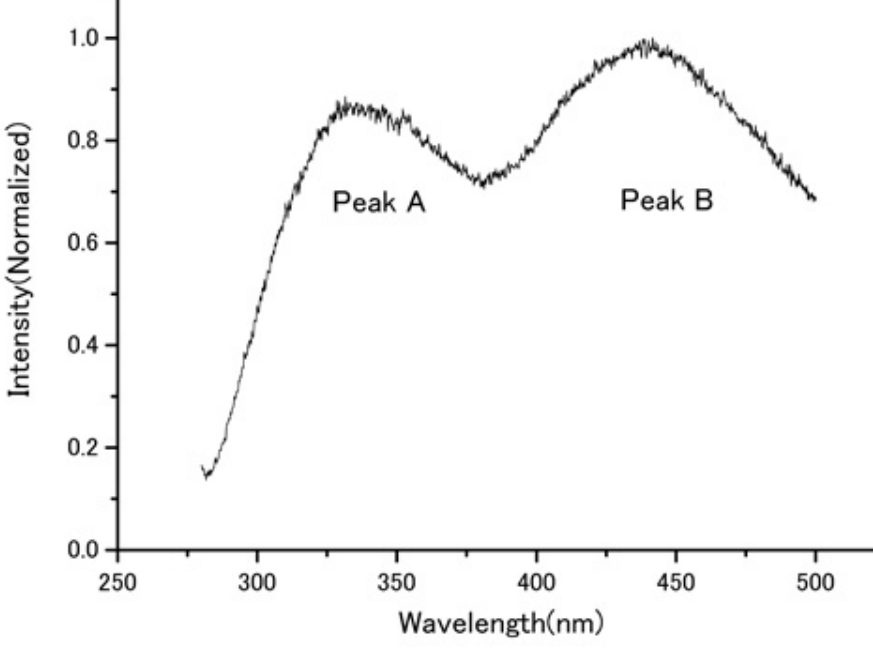
FIGURE 2 . Typical UV fluorescence spectrum of a fingerprint on quartz glass excited by 266-nm laser